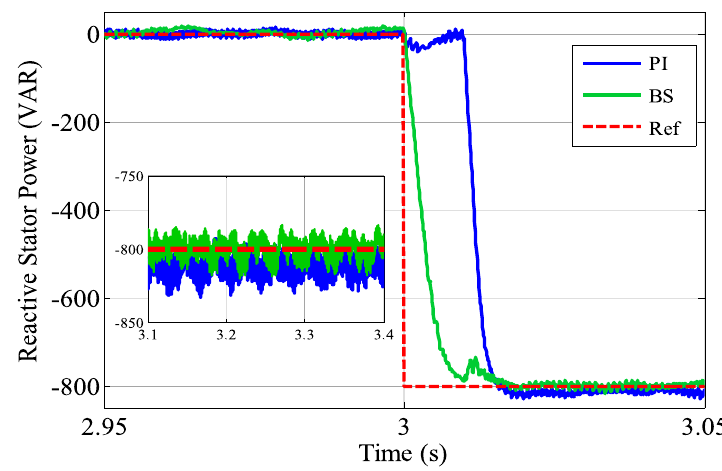
Fig. 20 Zoom on Reactive Stator Power Qs (VAR)